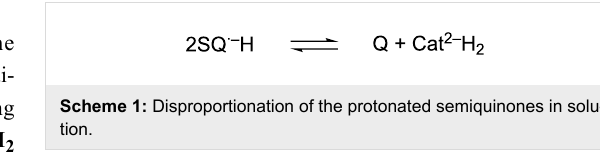
Figure 1: The structural formula of acceptor–donor–acceptor triad 1 .